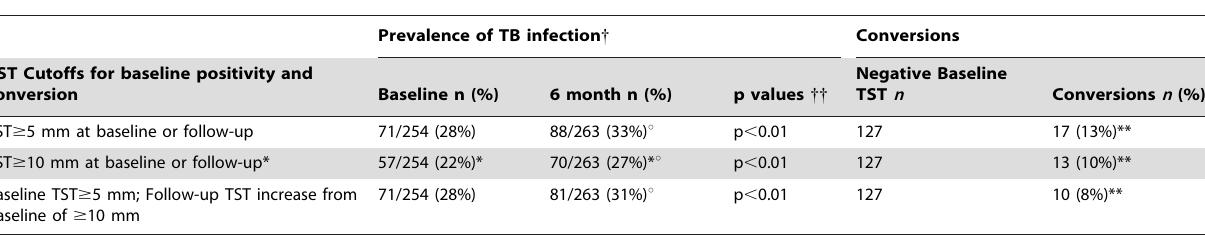
Table 3. Prevalence of TB infection and incidence of conversions using TST.